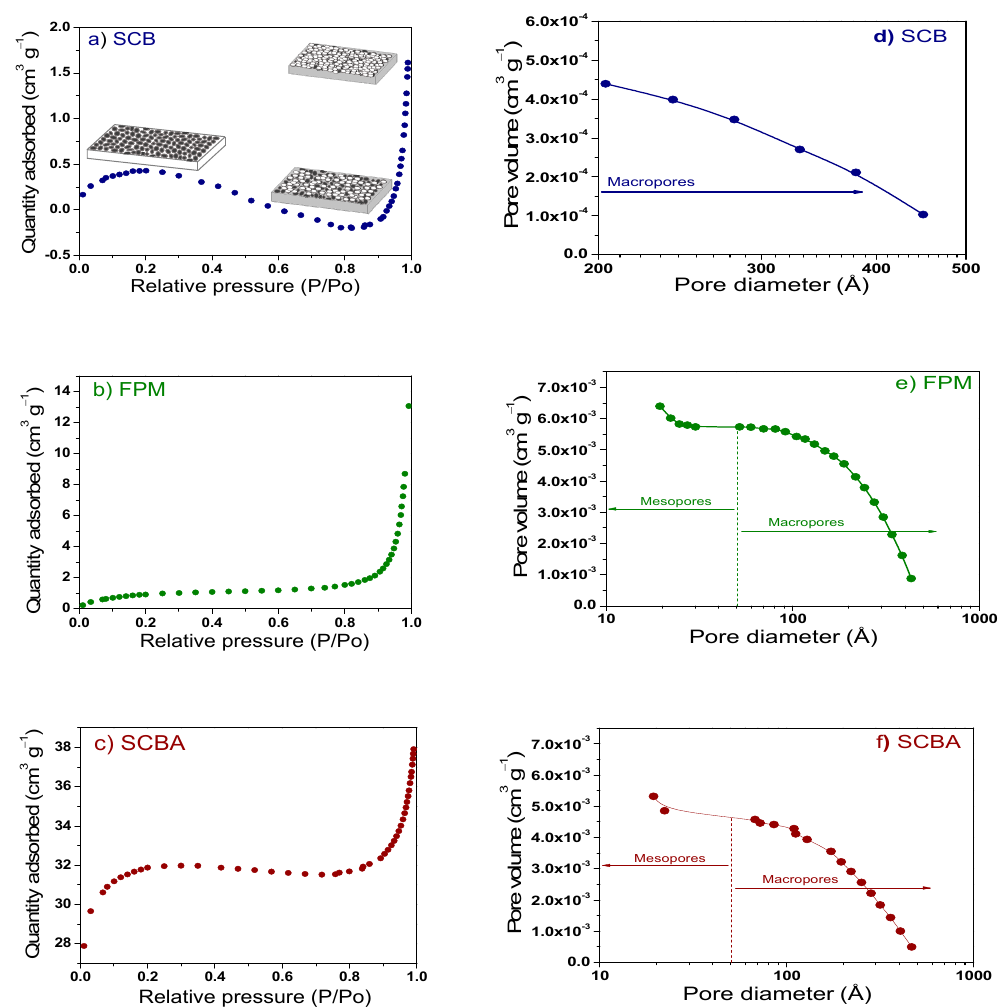
Figure 3. Nitrogen adsorption isotherms for raw materials obtained from sugar cane processing; ( a ) SCB, ( b ) FPM, and ( c ) SCBA. In this figure, it is also presented the pore distribution determined by BJH method for ( d ) SCB, ( e ) FPM, and ( f ) SCBA.